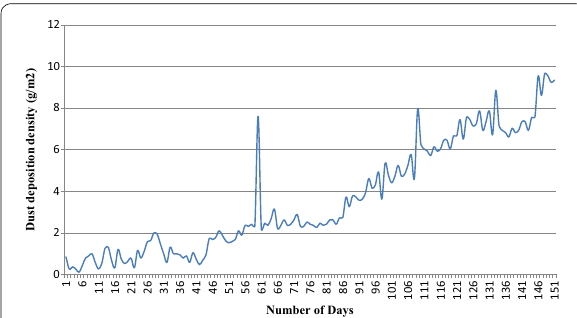
Fig. 8 Measured dust deposition density